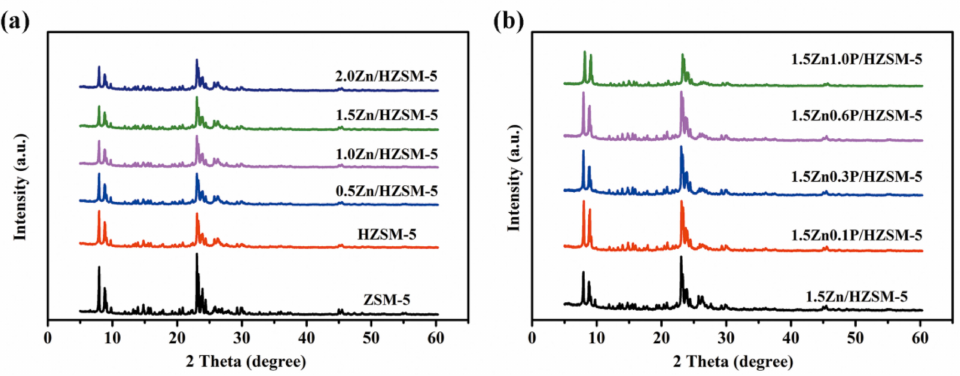
Figure 1. X-ray diffraction (XRD) patterns of ZSM-5, HZSM-5, Zn modified ( a ) and Zn-P co-modified ( b )